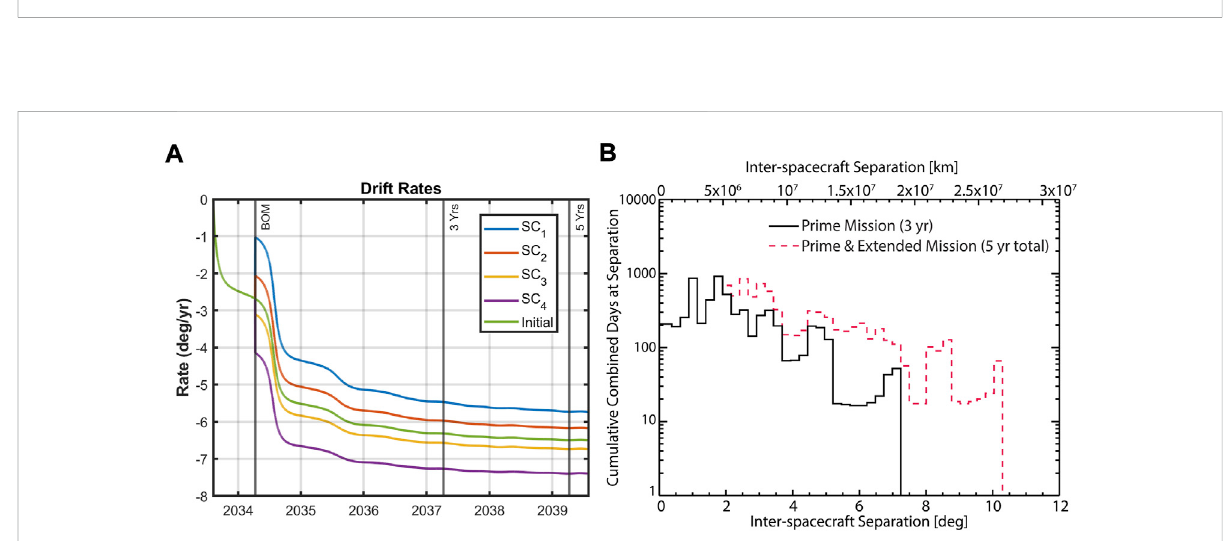
FIGURE 12 (A) Change in Earth-relative drift rate over the course of the mission. The “ initial ” line represents the drift rate targeted by the launch vehicle. (B) Cumulative combined days the InterMeso spacecraft spend at different inter-spacecraft separations over the prime mission (black) plus extended mission(red).Cumulativecombineddaysisthesumofthenumberofdaysspentateachseparationforeachspacecraftpair(i.e.,spacecraft1&2,1&3, 1&4, 2&3, 2&4, and